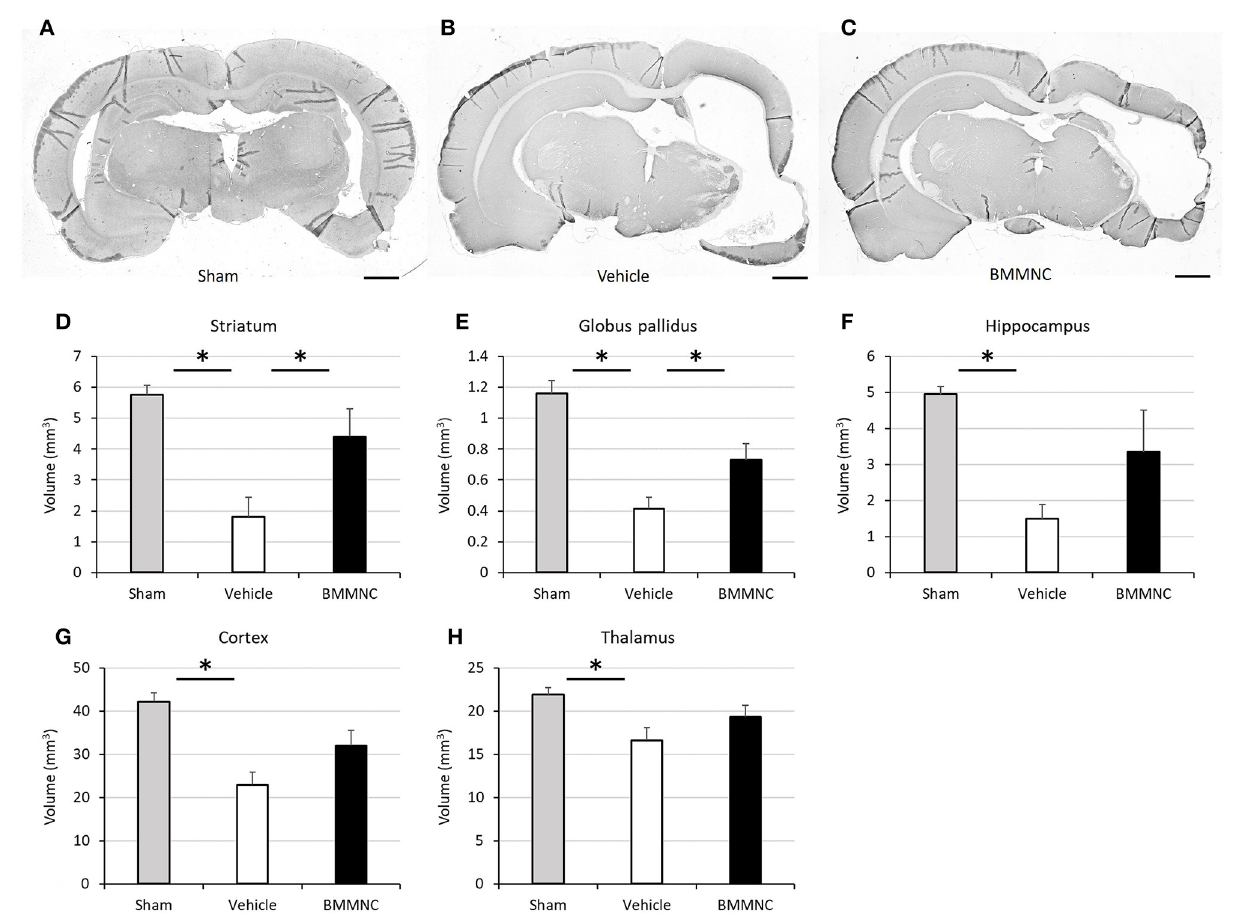
FIGURE 9 | Effect of BMMNC on histological changes after HI. The volumes of ipsilateral striatum and globus pallidus, hippocampus, thalamus, and cortex were evaluated according to the Cavalieri principle. (A–C) Representative photomicrographs of the brain stained for MAP2 from sham (A) , vehicle- (B), and BMMNC-treated rats (C) 6 weeks after HI. Bar = 1,000 µ m. The vehicle groups exhibited decreased tissue volume in every region (D–H) . The tissue volumes of ipsilateral striatum (D) and globus pallidus (E) were significantly larger in the BMMNC group than in the vehicle group. No significant difference was found between the BMMNC and vehicle groups regarding the volumes of hippocampus (F) , thalamus (G) , and cortex (H) . Data represent the mean ± standard error of the mean (sham, n = 9; vehicle, n = 8; BMMNC, n = 7) * p < 0.05, Dunnett’s